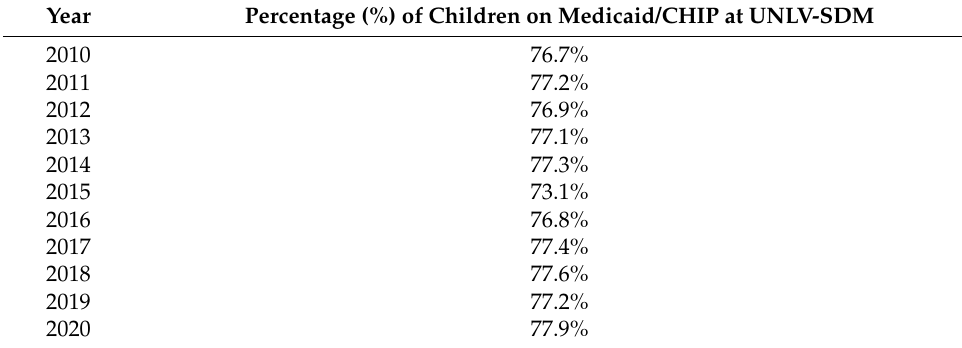
Table 3. Comparison of Pediatric Medicaid and CHIP enrollment over